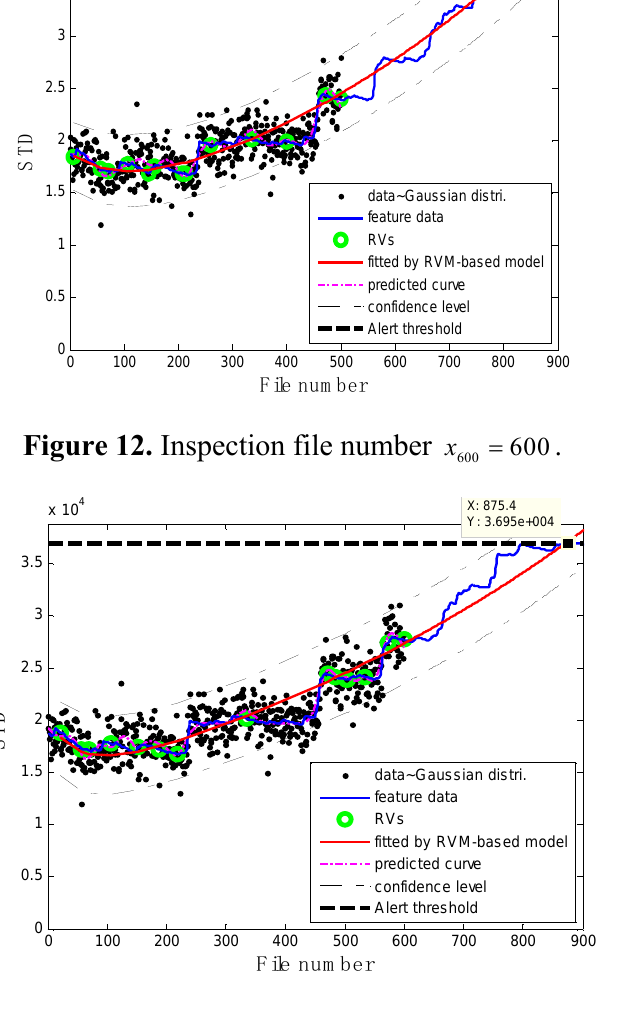
Figure 11. Inspection file number